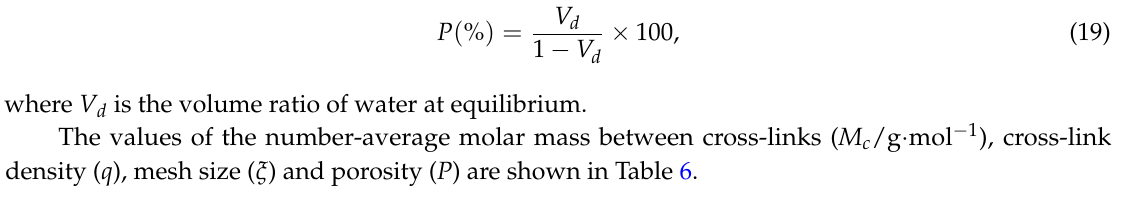
Table 6. The variation of the number-average molar mass between cross-links (M c /g · mol − 1 ), cross-link density ( q ), mesh size ( ξ ) and porosity ( P ) with the amount of TMPT, PP and absorbed dose.